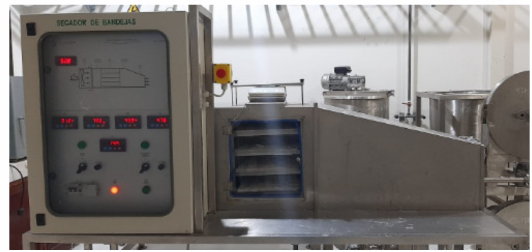
Figure 1. Drying